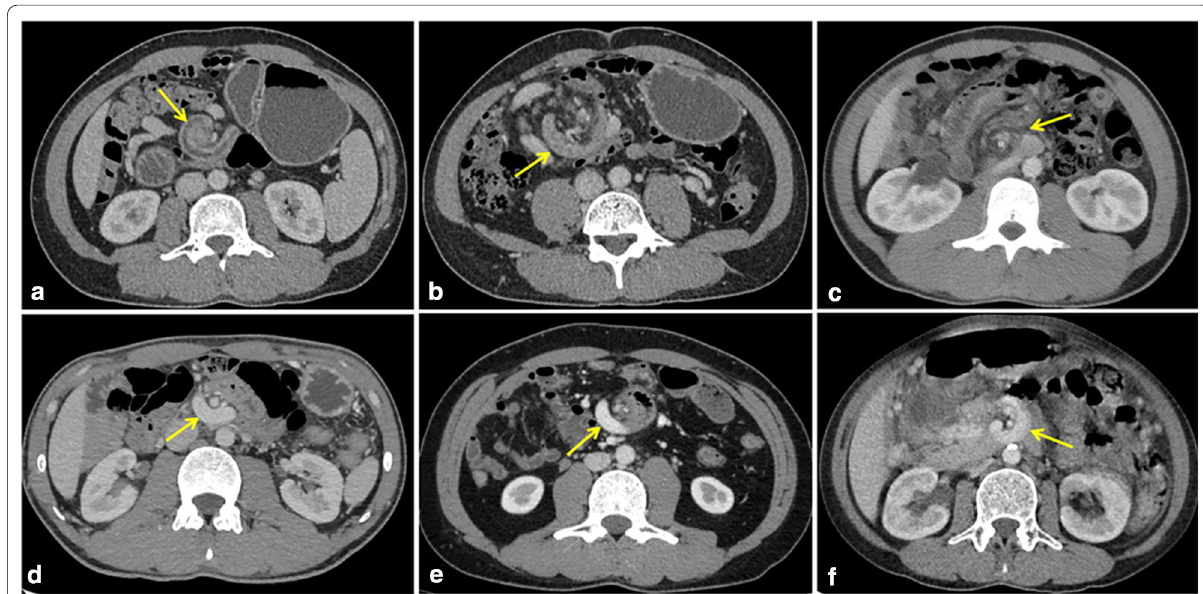
Fig. 4 “Whirlpool sign” in different patients. a , b A 34-year-old male with volvulus from the surgical group (D Y J R C R , type 4a). The images show torsion of duodenum, proximal jejunum and mesenteric vessels (arrow). c A 30-year-old male with volvulus from the surgical group (D Y J R C M , type 6). d , e Two males with volvulus from the conservative group (D Y J R C R , type 4a). The degree of torsion of vessels and intestines is mild (arrow). f A 51-year-old asymptomatic female (D Y J R C R , type 4a). The portal vein rotates anterior to the superior mesenteric